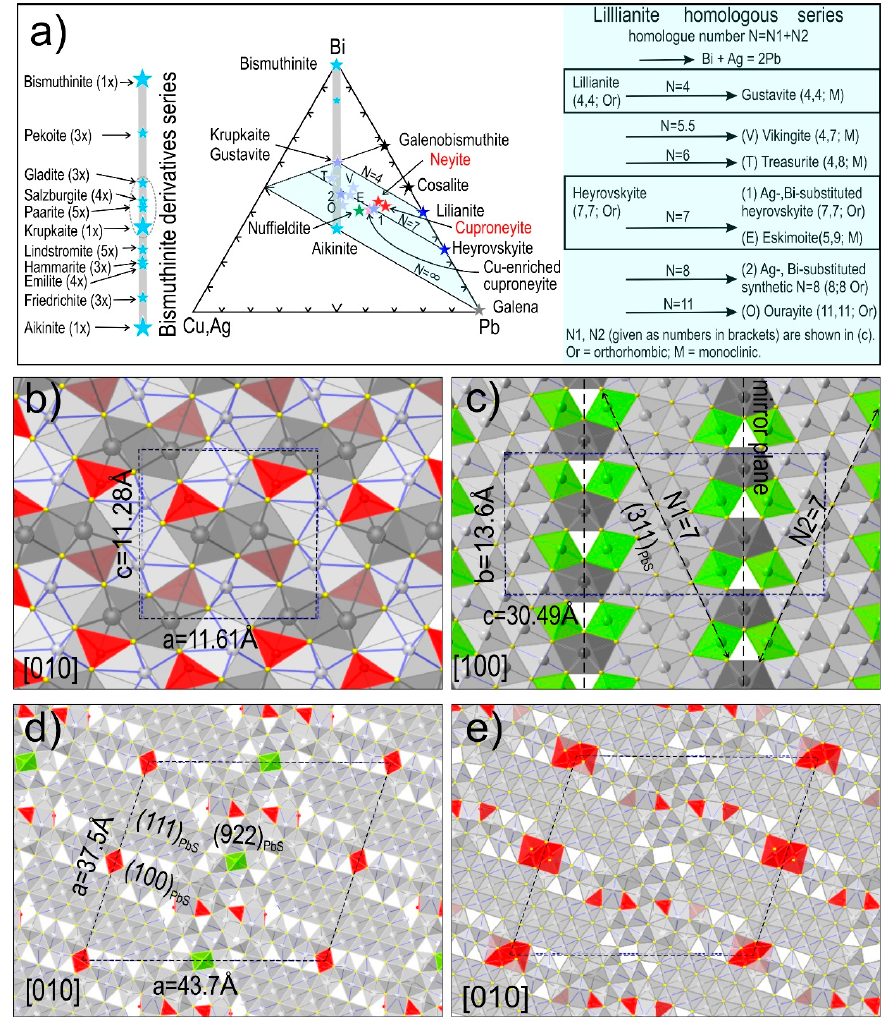
Figure 1. ( a ) Ternary (Cu, Ag)-Bi-Pb plot showing bismuth sulphosalts of interest in this study. Known species in the bismuthinite derivative series ( left ) and lillianite homologous series ( right ) are located on the plot; ( b – e ) Projection (as marked) of crystal structures for selected sulphosalts illustrating the main building blocks. Atoms are shown as balls: dark grey (smaller)—Bi; light grey (larger)—Pb; red—Cu; green—Ag; yellow—S. Coordination polyhedra are shown using the same colour code for each atom type; ( b ) Aikinite crystal structure [66] is built by Pb 2 S 6 ribbons (dark grey) with 4 Cu atoms filling adjacent tetrahedral voids and BiS 2+3 in monocapped prismatic polyhedra (light grey); ( c ) Ag-Bi-substituted heyrovskyite [74]. The bicapped trigonal prismatic PbS 6+2 position is along the mirror planes (dark grey), the other cations (Ag, Pb, and Bi) are present in the octahedral MeS 6 sites (light grey). The homologue number (N = 7 for heyrovskyite) represents the average of the BiS 6 octahedra along (311) PbS directions counted on each side of the mirror planes (N = N1 + N2); ( d ) Neyite [75], showing the main building blocks as marked; ( e ) Cuproneyite [76], differing from neyite in that three types of Cu sites are present (linear, triangular, and asymmetrically tetrahedral), and the Ag position is occupied by Cu atoms.